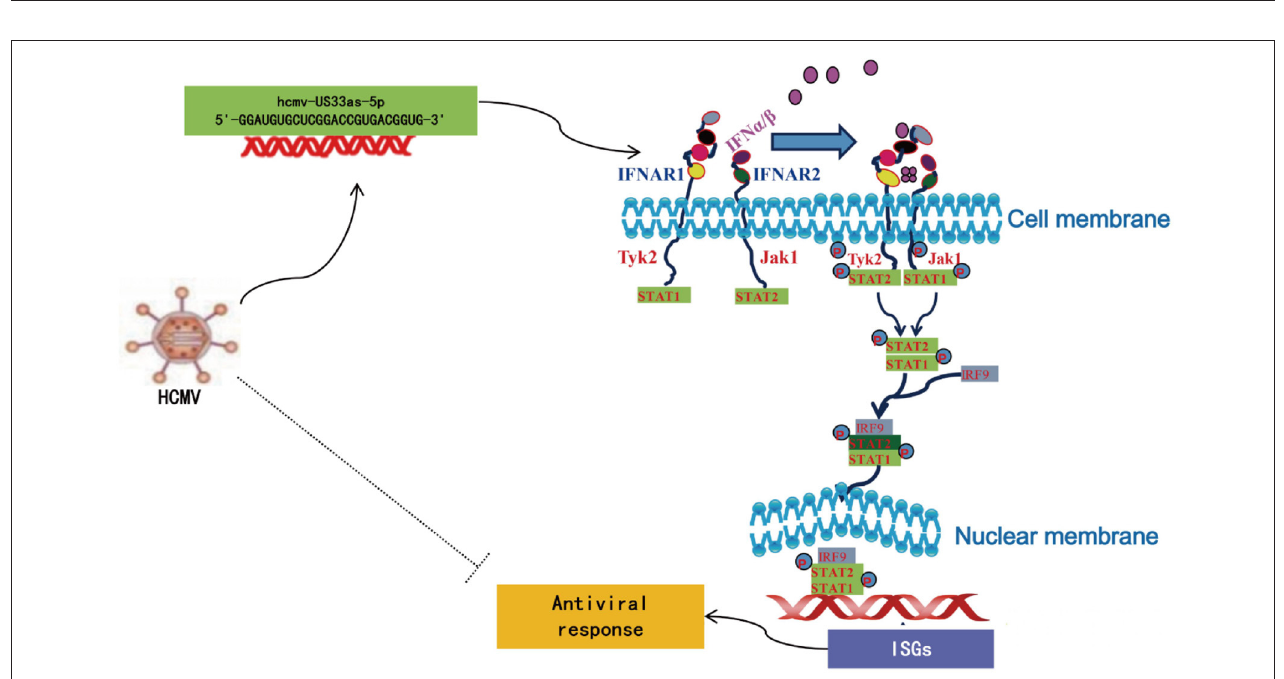
FIGURE 9 | Schematic of the mechanism by which hcmv-US33as-5p facilitates the IFN